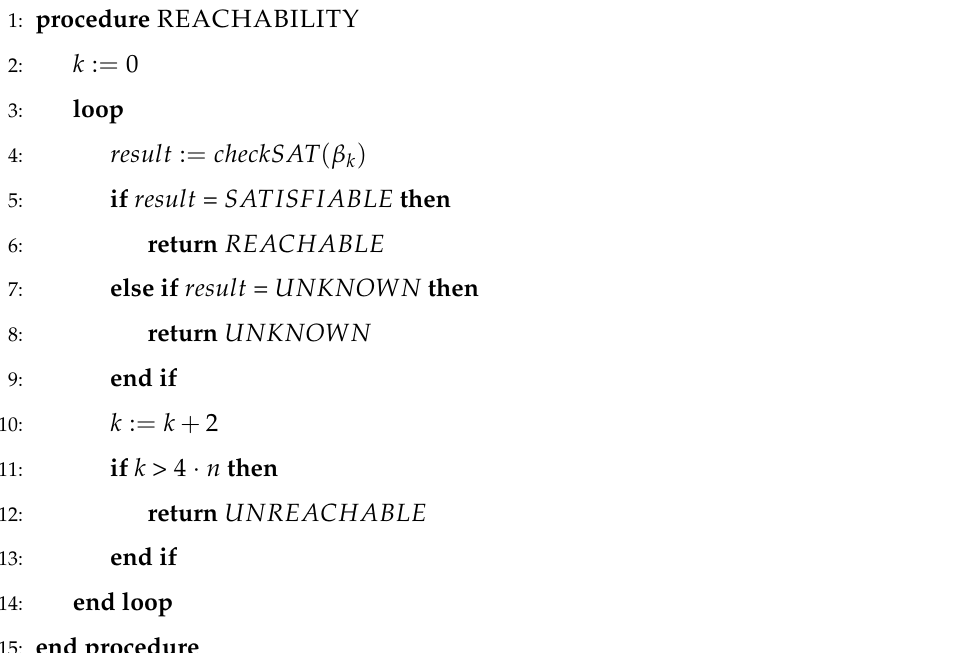
Algorithm 1 The standard BMC algorithm BMC for testing